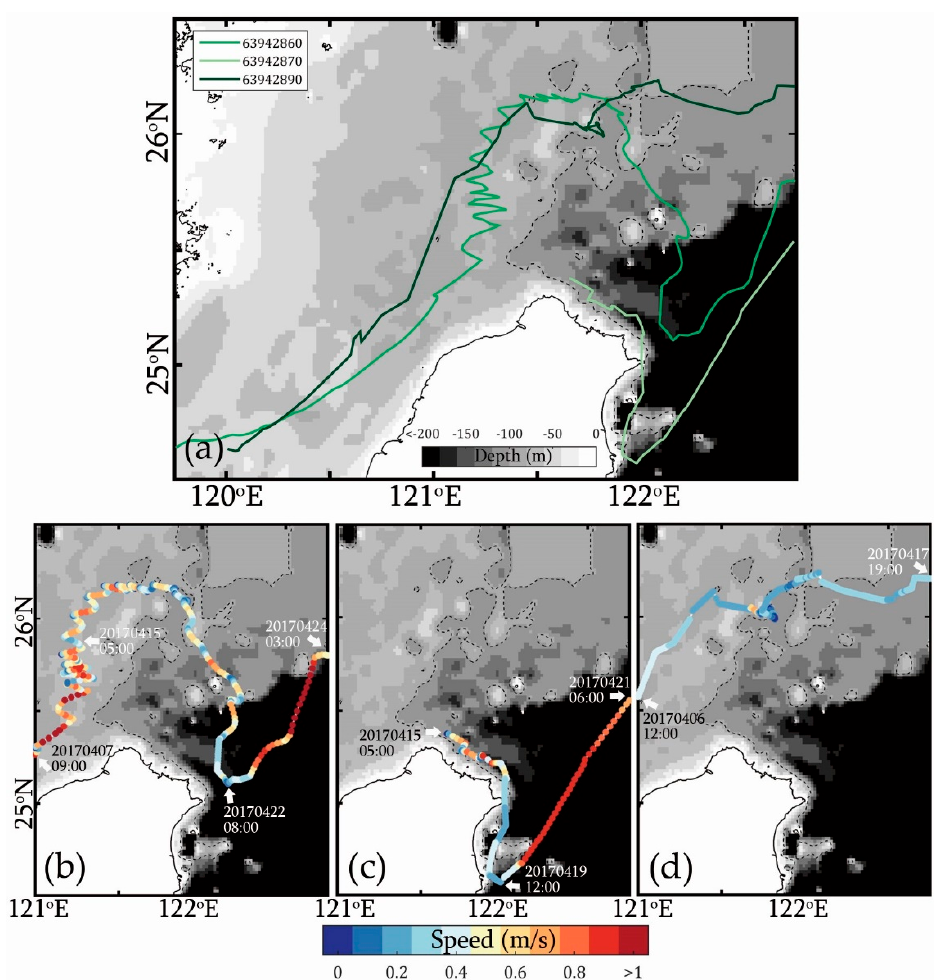
Figure 6. ( a ) Three trajectories of drifters in the Taiwan Strait in spring. ( b ) ID: 63942860, ( c ) ID: 63942870, and ( d ) ID: 63942890.